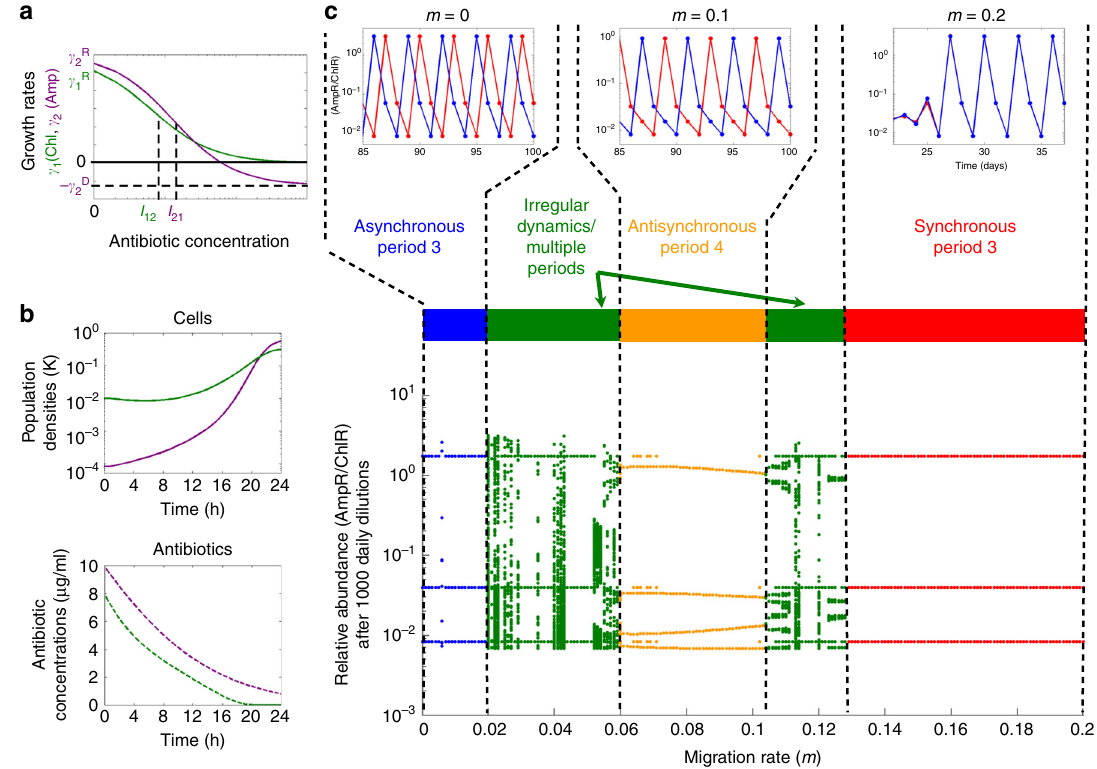
Fig. 4 A mechanistic model of antibiotic degradation captures the experimentally observed sequence of dynamical outcomes. a Dependence of growth rates on the concentration of antibiotics. b Simulated ampicillin resistant (AmpR) and chloramphenicol resistant (ChlR) cell densities (top panel) and antibiotic concentrations (bottom panel) over the course of one 24 h growth cycle, shown in purple and green, respectively. c Bifurcation diagram for a simulation of two co-cultures in a benign environmental condition (10 μ g/ml of ampicillin, 8 μ g/ml of chloramphenicol) as a function of the migration rate m . Unique values of the subpopulation density ratio (AmpR/ChlR) attained by patch A at the end of the growth cycle over the last 50 days of a simulation with 1000 daily dilutions are plotted for each migration rate. The simulations are deterministic. The diagram captures the sequence of observed dynamical outcomes: asynchronous period-3 oscillations in the absence of migration, period-4 oscillations and irregular dynamics at intermediate migration rates, and synchronous period-3 oscillations at large migration rates. The insets in c show representative time series for m = 0, m = 0.1, and m = 0.2. Model parameters can be found in Supplementary Table